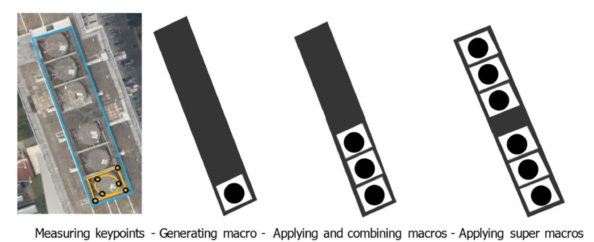
Figure 6. Basic idea of measurement macros